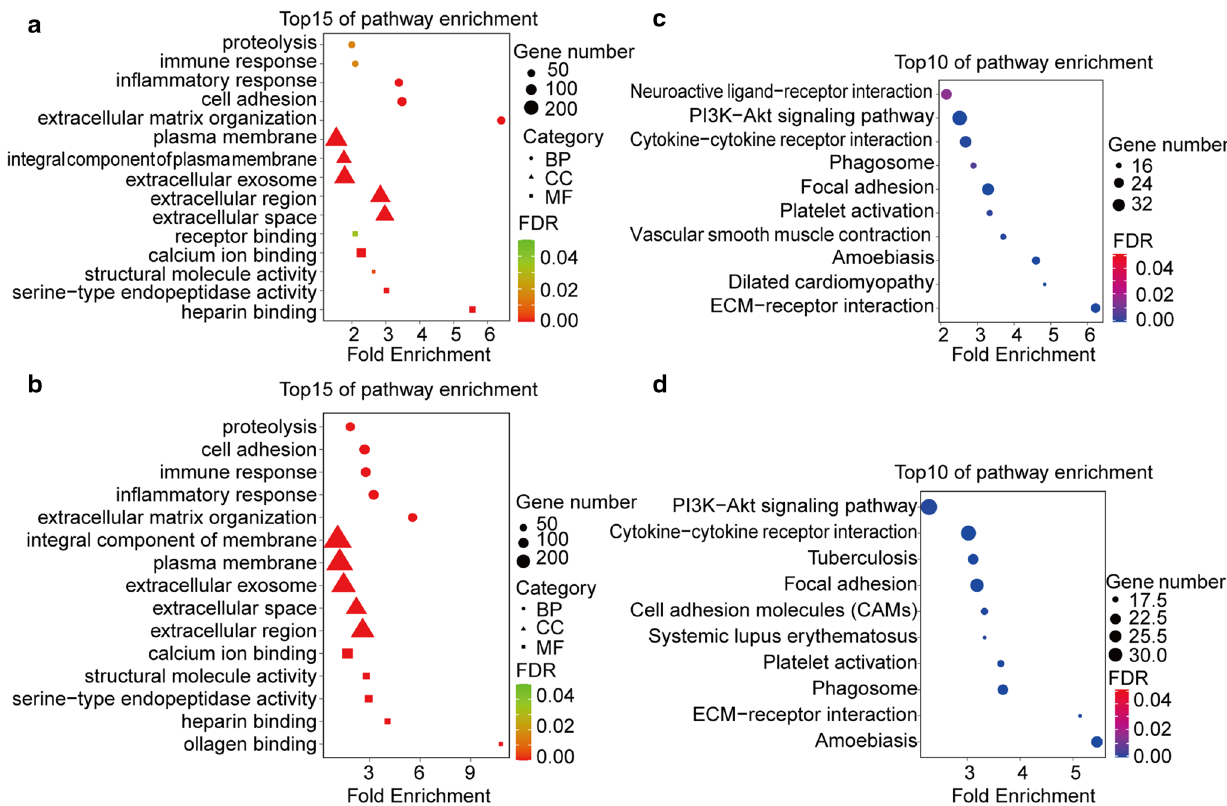
Fig. 3 Functional enrichment clustering analysis for DEGs. a , b Top15 significant GO terms based on Stromal/ESTIMATE Score. c , d Top 10 KEGG terms based on Stromal/ESTIMATE